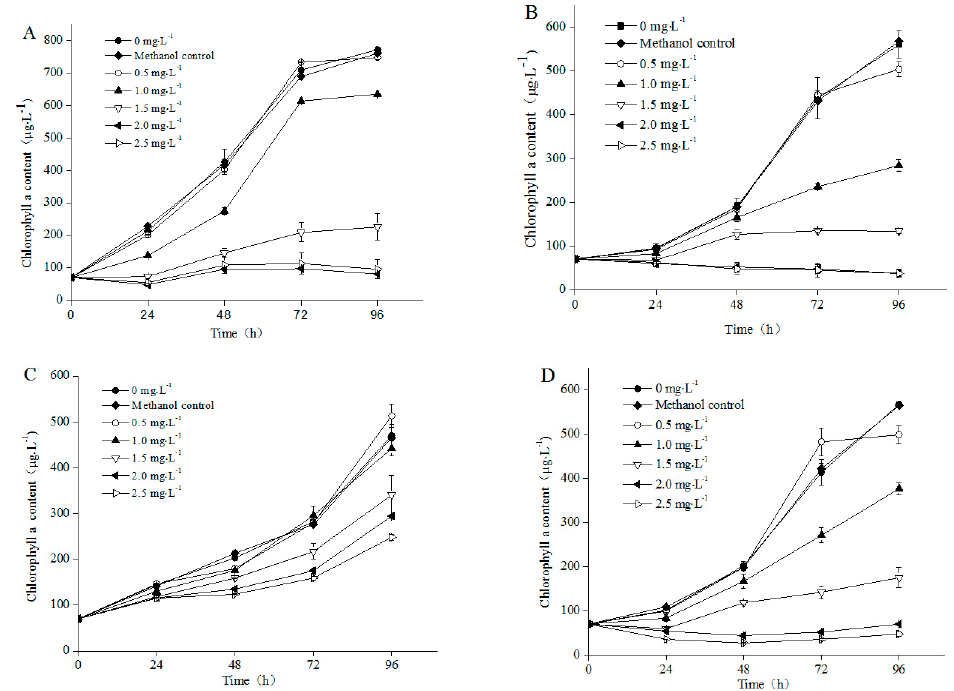
Figure 1. Effect of Nonylphenol (NP) concentration on the chlorophyll a content of ( A ) A. acicularis ; ( B ) C. minutus ; ( C ) C. vulgaris and ( D ) S. quadriauda , Values are the mean ± standard deviation (SD) ( n = 3).